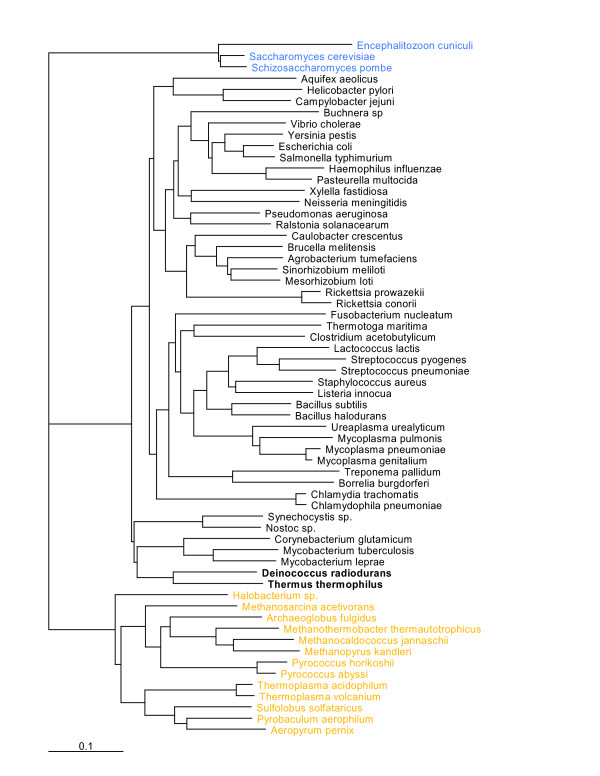
Gene content tree constructed for 66 species included in the COG database on the basis of the patterns of presence-absence in the COGs. The Thermus-Deinococcus clade is marked by bold type. Black, bacteria; yellow, archaea; blue, eukaryotes.